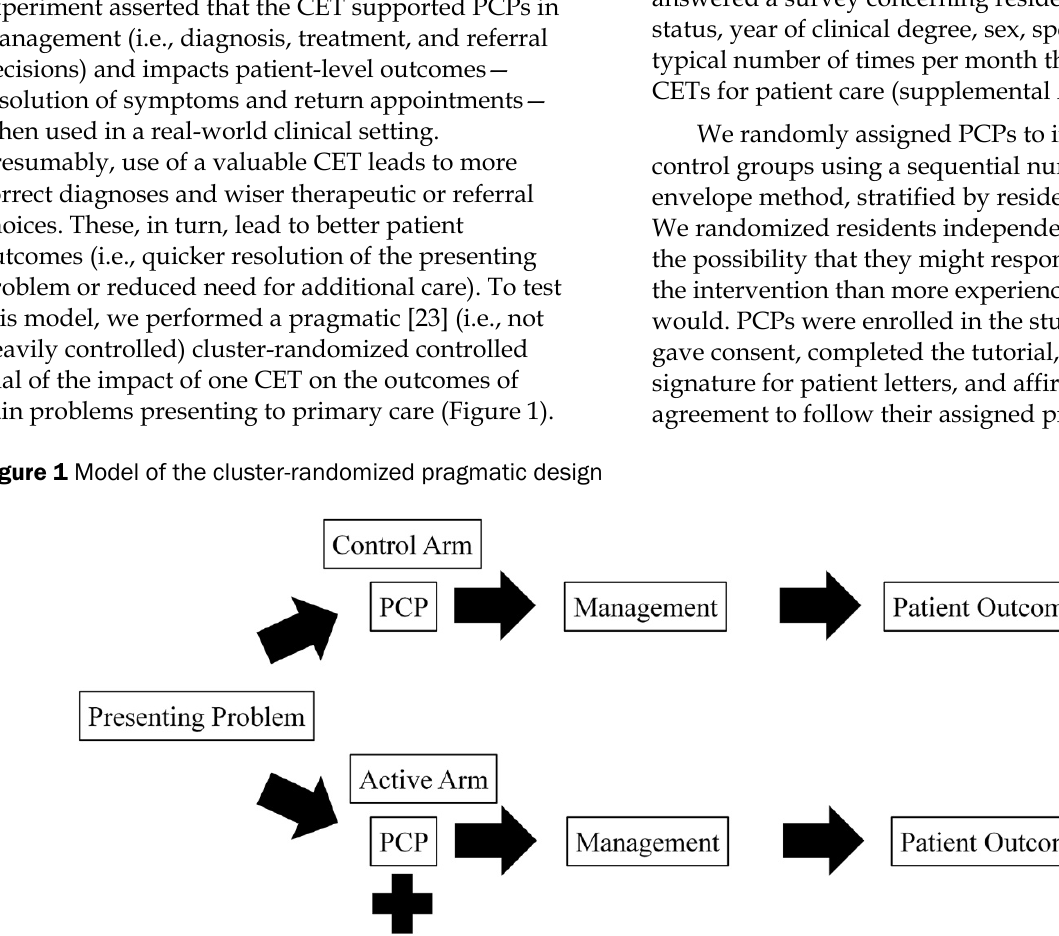
PCP=primary care provider; CET=clinical evidence